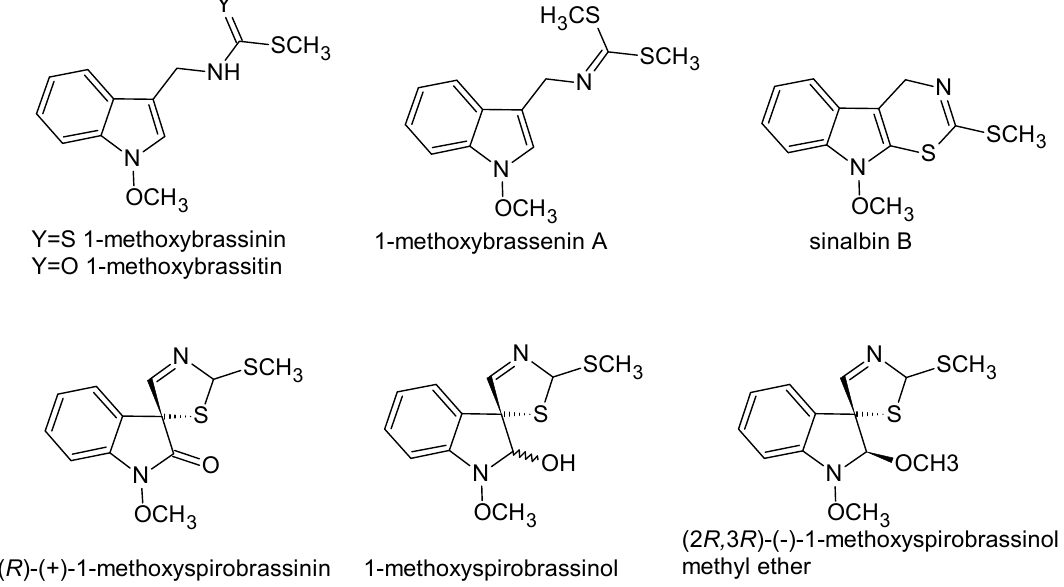
Figure 1. Structures of indole phytoalexins.